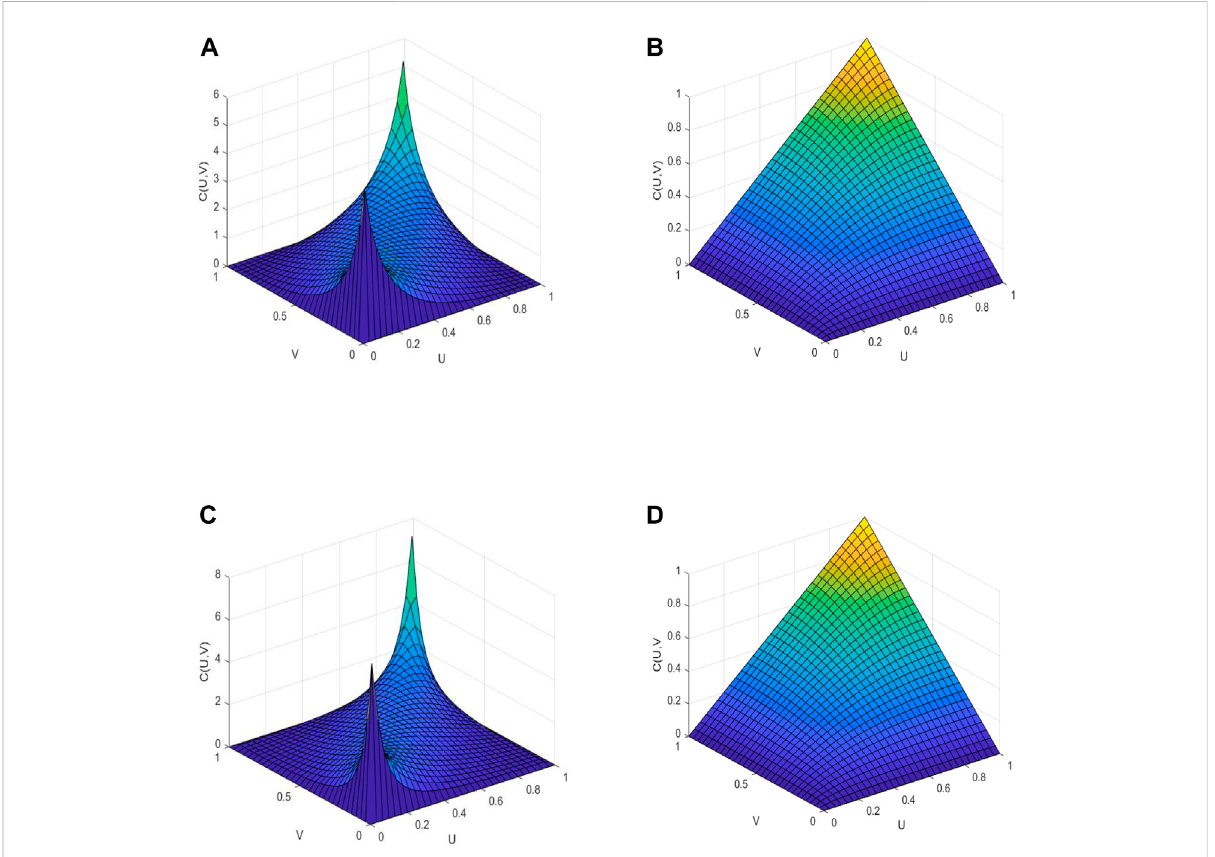
FIGURE 4 Bivariate density function and bivariate distribution fuction of the Gaussian-Copula function and the t-Copula function (A) bivariate Gaussian- Copuladensityfunction, (B) BivariateGaussian-Copuladistributionfunction, (C) bivariatet-Copuladensityfunction, (D) Bivariatet-Copuladistribution function.